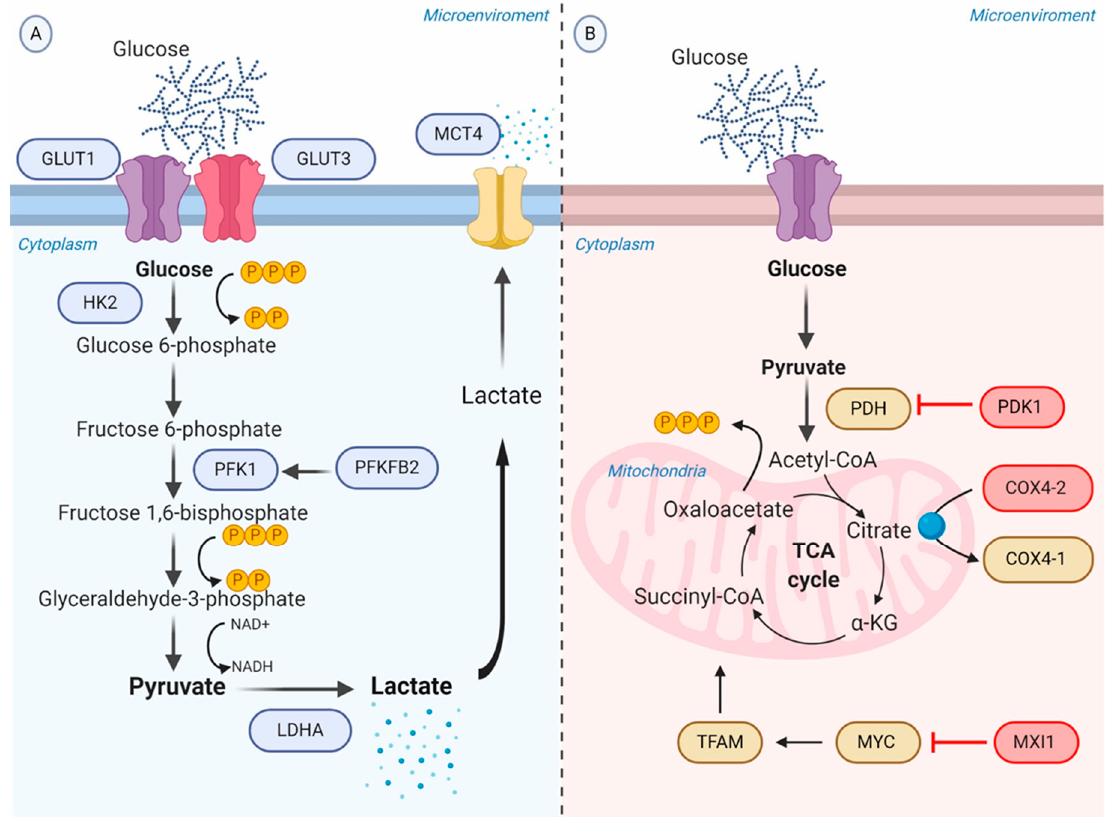
Figure 2. Schematic representation of the glycolytic switch mediated by tumor hypoxia. ( A ) Regulation of genes encoding glycolytic enzymes involved in the promotion of anaerobic glycolysis. GLUT1 and GLUT3 overexpression increase the rate of glucose import. HK2 phosphorylates the intracellular glucose to glucose 6 ‐ phosphate. PFK1, produced by PFKFB2 or induced by HIF ‐ 1 α , converts Fructose 6 ‐ phosphate into Fructose 1,6 ‐ bisphosphate and ADP. LDHA catalyzes pyruvate into lactate with concomitant generation of NAD+ from NADH. MCT4 transports lactate to the extracellular environment. ( B ) Repression of OXPHOS. PDK1 inactivates PDH and blocks the conversion of pyruvate to acetyl ‐ CoA. MXI1 inhibits the transcriptional activity of MYC and thereby inactivates MYC target genes (e.g., TFAM) involved in OXPHOS and mitochondrial dynamics,